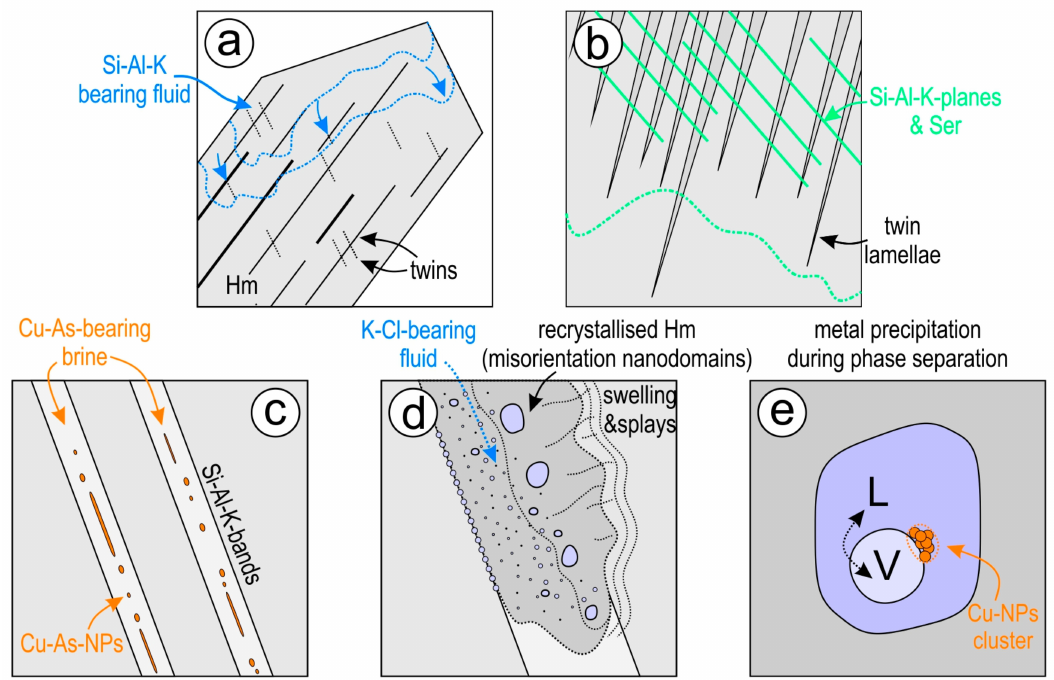
Figure 17. Schematic showing formation of metal NPs along fluid inclusion trails in hematite during fluid-mineral interaction. ( a ) Plan view of weave-twinned hematite interacting with incoming Si-Al-K-bearing fluids typical of hydrolytic alteration in IOCG systems. ( b ) Cross-section of a reacted domain within hematite in which the channels of fluid percolation led to nm-wide Si-Al-K-planes that become coarser bands and / or sericite platelets. Various defects occur in hematite at the junction between the twins and fluid channels. ( c , d ) The fluid compositionally evolves into a Cl- and metal-bearing brine that interacts with the pre-existing Si-Al-K planes and sericite. Initially, rates of fluid percolation are slow, and the reaction leads to formation of Cu-As NPs with variable Cu / As ratios, whereas some of the Si-Al-K-filling of the planes is removed ( c ). Rapid and / or erratic fluid flow driven by fault-valve mechanisms produce fronts of reaction via CDRR along preferential sets of Cu-As-enriched and Si-Al-K-depleted bands ( d ). This leads to formation of complex trails with smallest Si-hematite NPs on one side and coarsest fluid inclusions within swells on the other side of the trail. The reacted area along the trails is filled with nanoprecipitates of hematite (dark grey) recognised by nanodomains with 2-fold superstructures, twins and misorientation. Fluid inclusions are trapped within transient pores produced during CDRR development. ( e ) Metal-bearing NPs (Cu-, Cu-As-, Mo-, and W-bearing NPs) are precipitated within the fluid inclusions during fluid-vapour phase separation. The latter is induced by sudden depressurization during fault-valve fluid